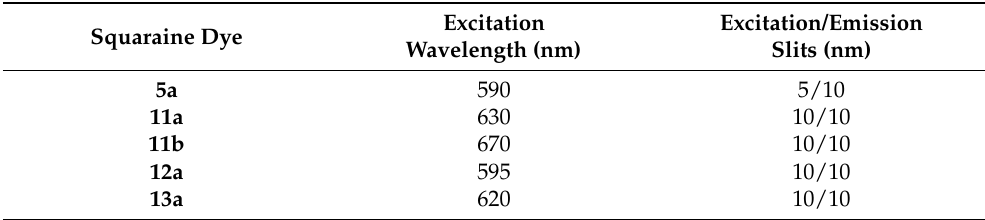
Table 1. Excitation wavelength and excitation/emission slit width values used for squaraine–protein binding fluorescence intensity